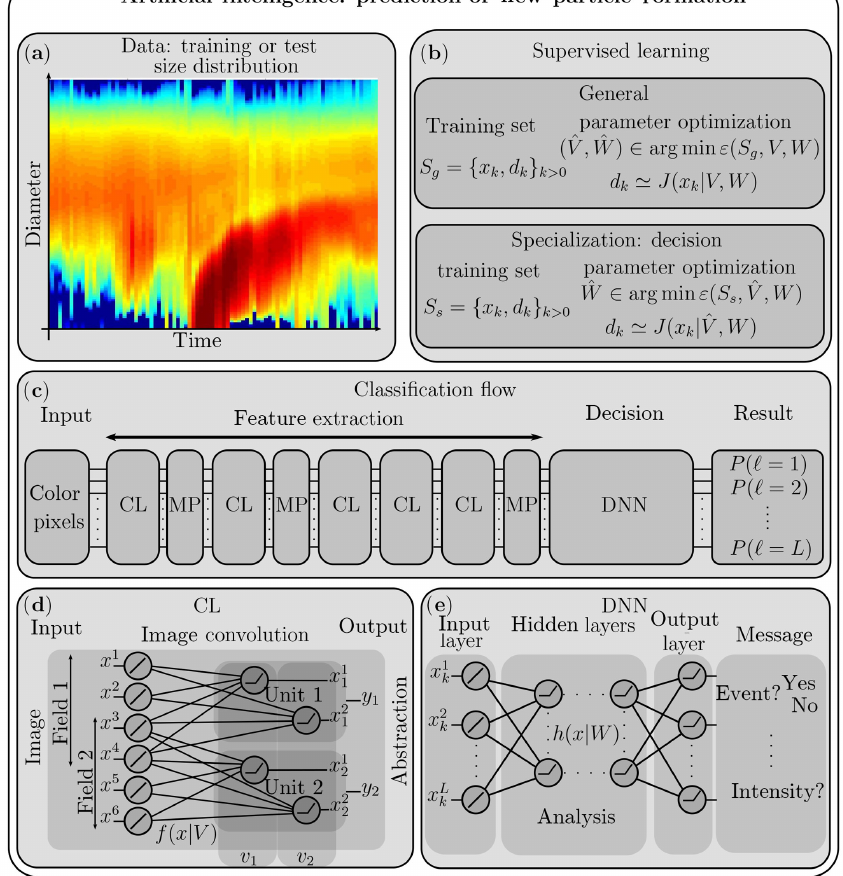
Figure 2. Visual summary of the classification method: (a) a typical dataset with a NPF event, (b) the learning process of the optimization problem, (c) the classification flow of the convolutional neural network (CNN) and the two types of layers of the CNN, (d) the convolutional layer (CL), and (e) the deep neural network (DNN), involved in the total CNN. The classification flow (c) is from the AlexNet CNN (Krizhevsky et al., 2012), composed of 5CL intertwined with max pooling (MP) layers followed by a fully connected DNN of three layers. The method and variables in the figure are described in detail in Sect. 2.3 and Appendices A and